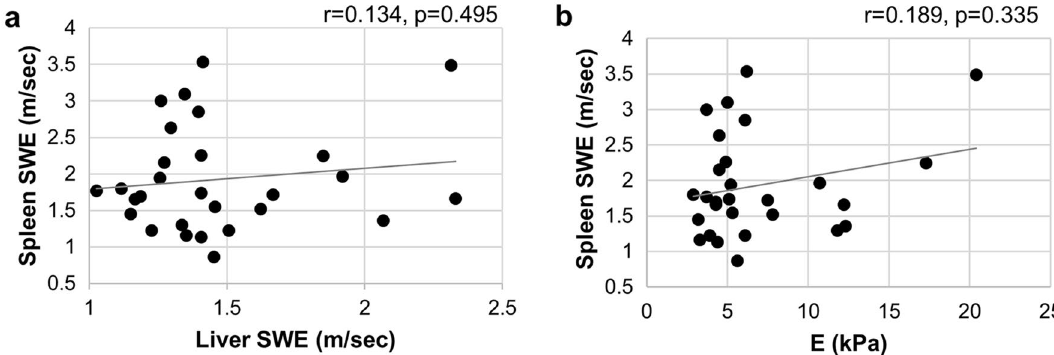
Figure 3. Correlation between the change in spleen stiffness obtained by SWE and liver stiffness by ( a ) 2D-SWE, and ( b ) TE with Fibroscan.